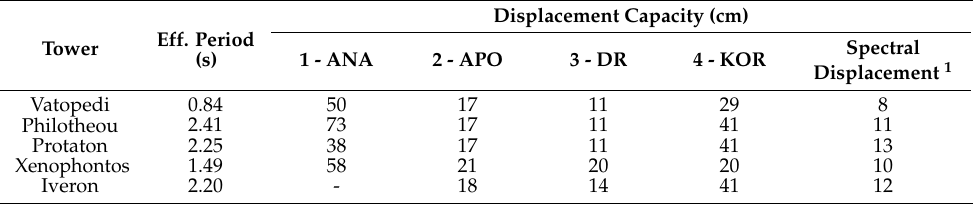
Table 6. Out-of-plane collapse mechanisms: spectral displacements.